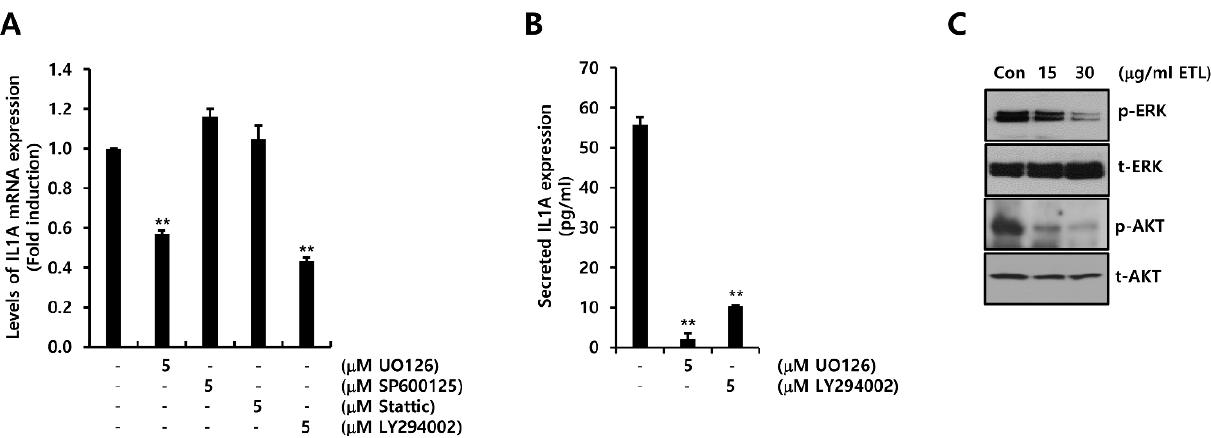
Figure 6. ETL downregulates human IL1A expression by preventing the MEK/ERK and PI3K/AKT signaling pathway in MDA231 TNBC cells. ( A , B ) after cell-seeding, 5 µ M of inhibitor was treated to the cells for 24 h. The levels of IL1A mRNA ( A ) and protein ( B ) were measured through real-time PCR and ELISA, respectively. ( C ) the levels of p- and t-ERK and AKT were measured through Western blotting. The values are presented as the mean ± standard error of three independent experiments. ** p < 0.01 vs. Con. Con; control, ETL; Entelon ® .